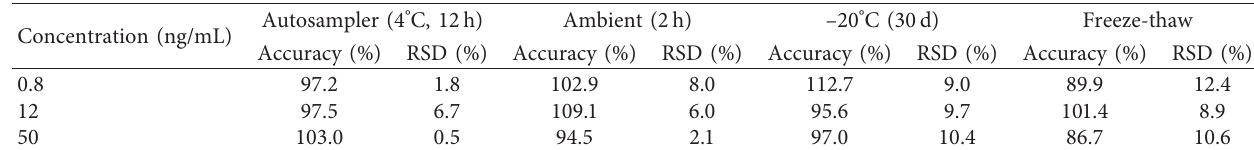
Table 2: Summary of the stability of 10-hydroxy mesaconitine under various storage conditions ( n �